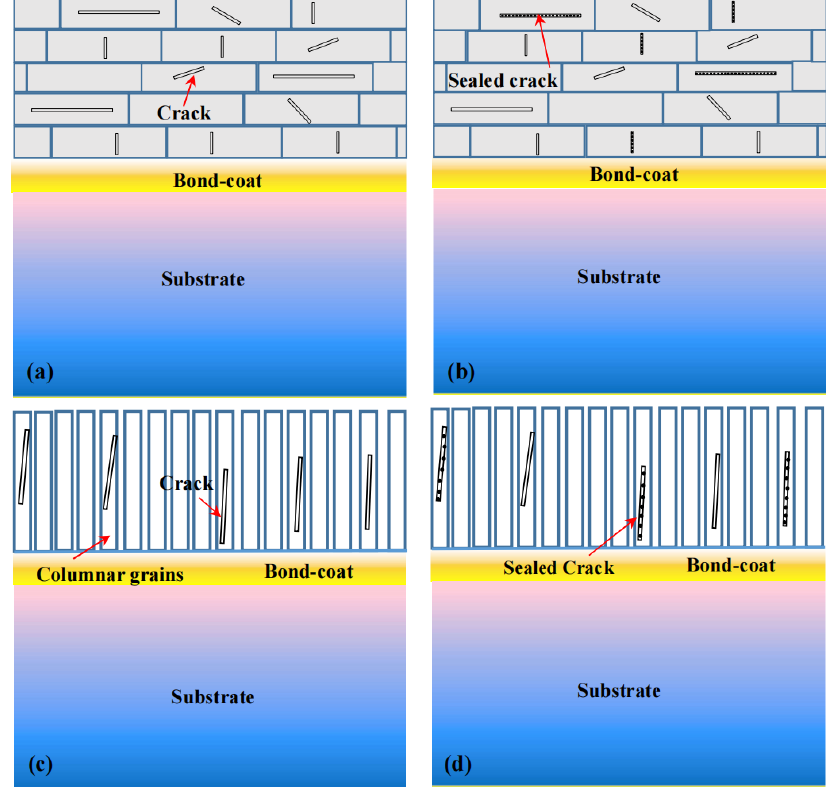
Figure 14. Schematic illustration of self-healing TBCs with different micro-structures. TBCs with lamellar micro-structure ( a ) before self-healing and after self-healing ( b ); TBCs with columnar micro-structure ( c ) before self-healing and after self-healing ( d ).